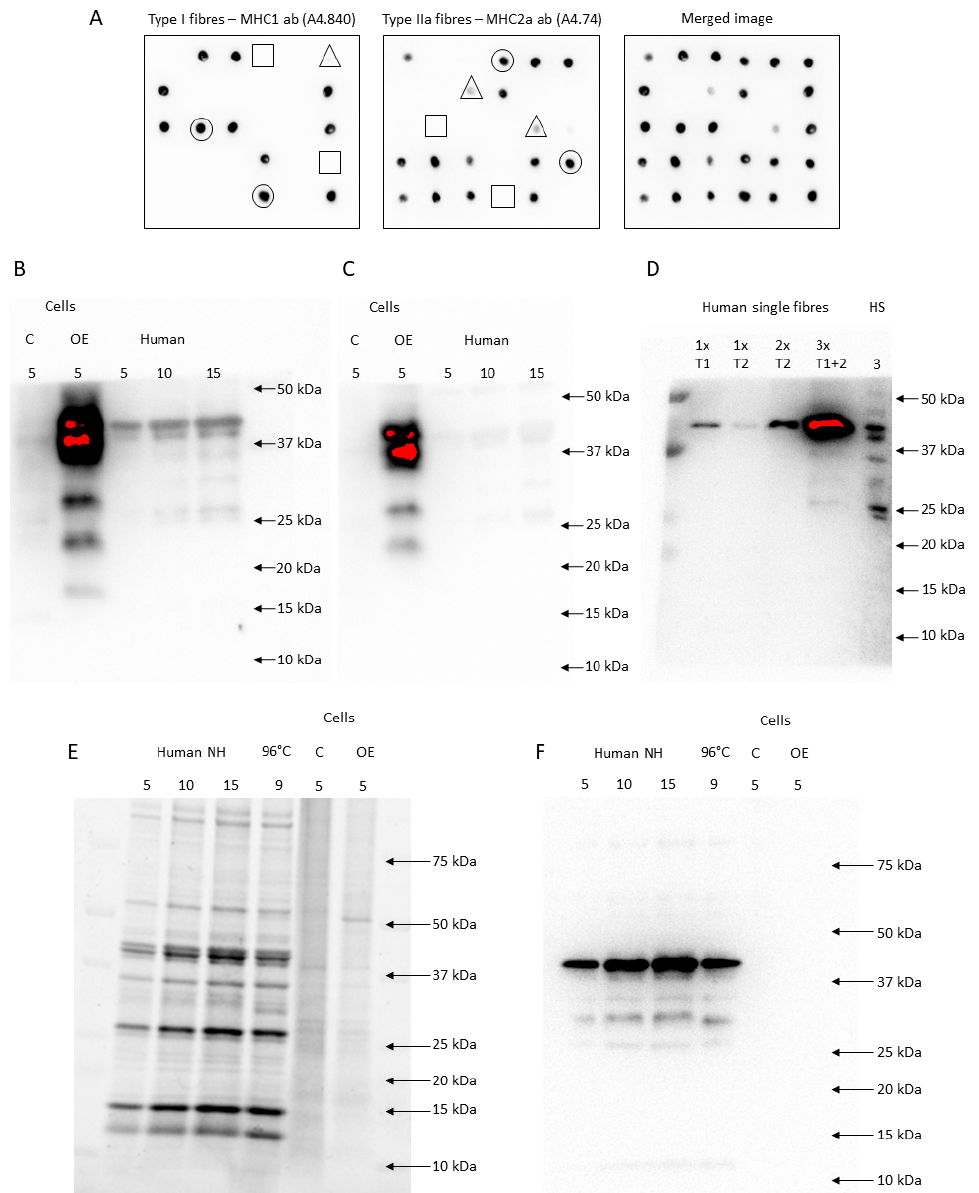
Figure 5. Dot blotting and FXYD5 antibody validation (HPA010817 and SC-166782). ( A ) Shows dot blotting of 6 × 5 fibre segments incubated with either an MHC1 or MHC2a antibody. Each dot was evaluated as no signal ( □ ), a weak signal ( ∆ ), or a clear signal ( ○ ). ( B , C ) HPA010817 ( B ) and SC-166782 ( C ) antibodies showed a clear multiple-band signal (19–40 kDa and 22–40 kDa, respectively) in FXYD5 overexpression samples (OE) compared to the control (C) and human muscle lysates. ( D ) In the first two lanes, one segment of type I (T1) and type IIa fibre (T2), respectively, was loaded. In the third lane, two pooled type IIa fibres were loaded, while pooled segments from three different fibres were loaded in lane four. In lane five, 3 µg human skeletal muscle lysate was loaded. The membrane was incubated with HPA010817. ( E ) The stain-free image is shown from loaded human skeletal muscle lysates either non-heated (NH) or heated for 3 min at 96 °C (96 °C) and FXYD5 OE and C samples. ( F ) Shows the membrane after incubation of the samples from ( E ) with an anti-actin antibody. 4.4.6. Immunoblotting and SDS Page We performed immunoblotting on muscle fibre pools, as previously described [59]. We loaded an equal amount of the pooled type I and type IIa fibres from the same subject